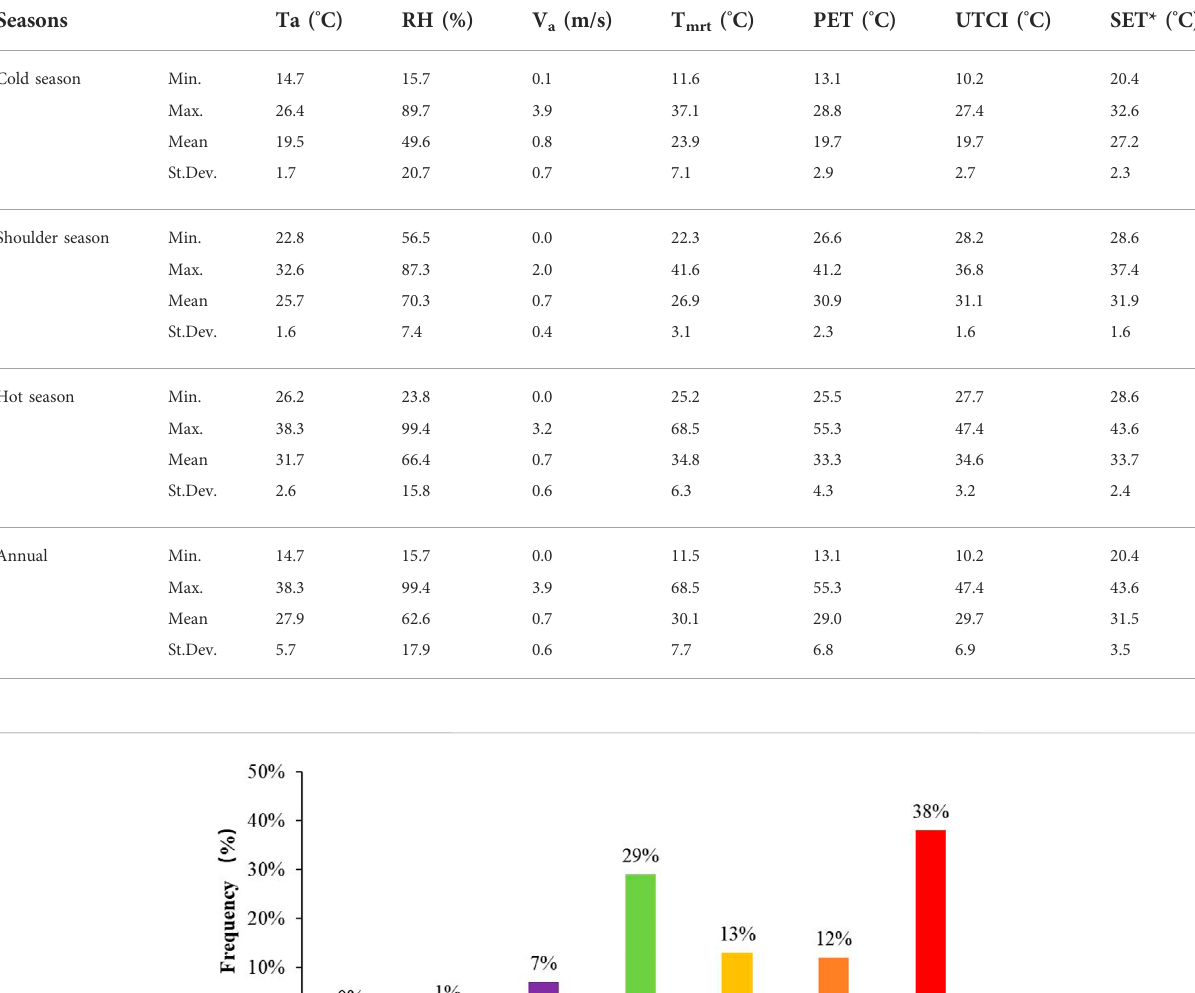
TABLE 5 The statistical results of the microclimate parameters. Seasons